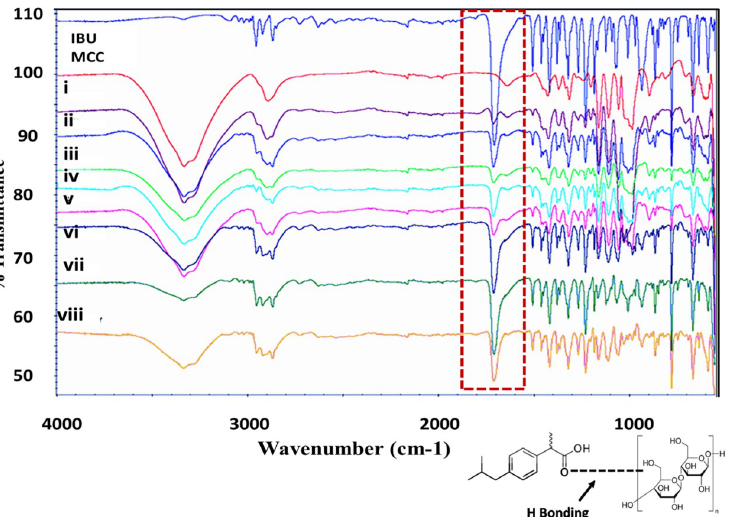
Fig 4. FTIR spectra from top to bottom of ibuprofen (IBU) powder, MCC powder, (i) 2%w/w IBU in MCC coated mixture, (ii) 2%w/w IBU in MCC before coating, (iii) 5%w/w IBU in MCC coated mixture, (iv) 5%w/w IBU in MCC before coating, (v)10%w/w IBU in MCC coated mixture, (vi) 10%w/w IBU in MCC before coating and (vii) 20%w/w IBU in MCC coated mixture, (viii) 20%w/w IBU in MCC before coating highlighting the reduction in the intensity of the peak at wave number 1708 cm -1 (labelled with red rectangle) of ibuprofen that is attributed to C = O due to the formation of hydrogen bonding between the hydroxyl (OH) and (C = O) groups. Lower diagram highlighting the hydrogen bonding formation between ibuprofen and